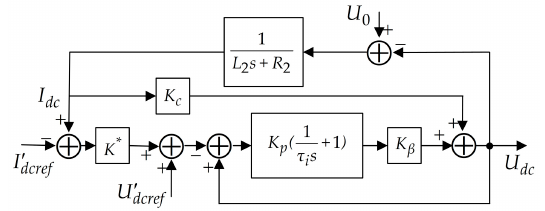
Figure 11. Transfer function block diagram of LCC employing adaptive droop